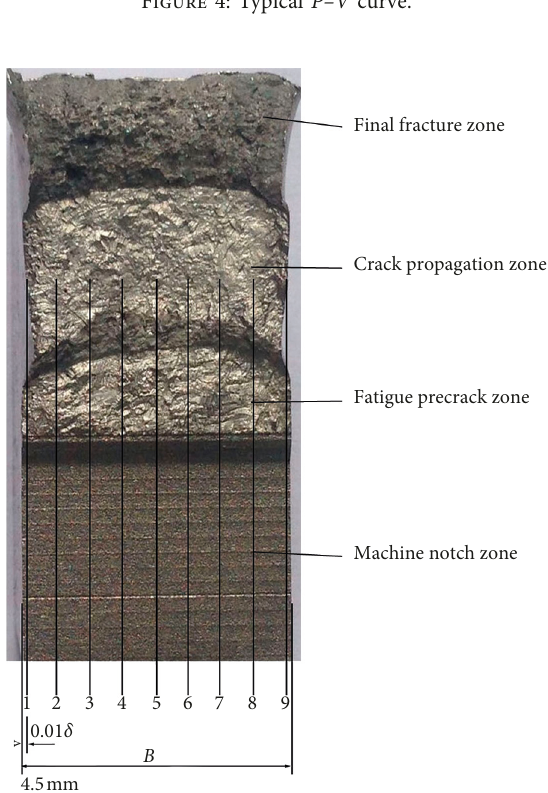
Figure 5: Measure of a